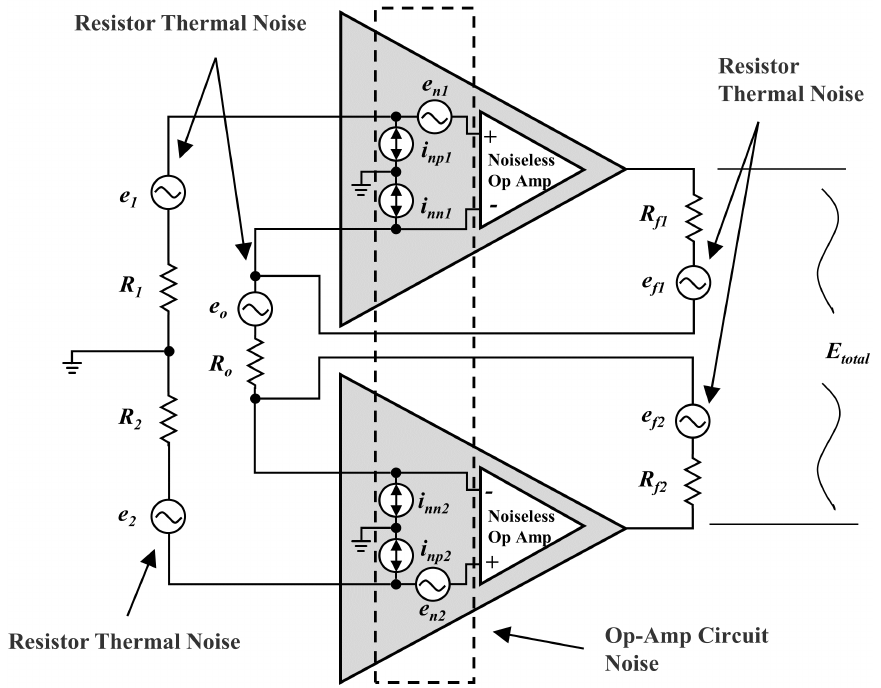
Figure 3. The equivalent noise circuit diagram of the dual op − amps full differential neural record- ing front